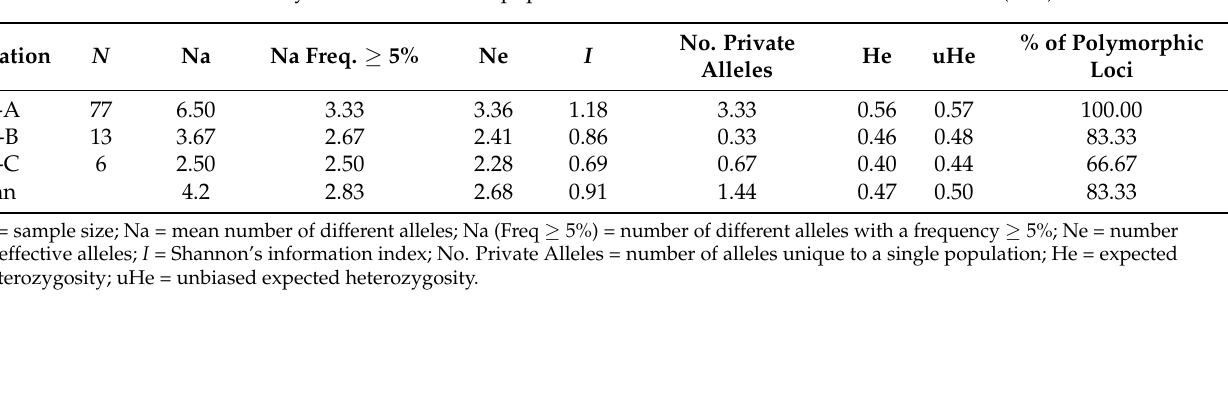
ArR01D MAF (major allele frequency), Gn (number of genotypes), Na (number of alleles), Ne (number of effective alleles), I (Shannon’s information index), Gd (gene diversity), Ho (observed heterozygosity), He (expected heterozygosity), PIC (polymorphic information content), uHe (unbiased expected heterozygosity), Nm (Number of migrant (gene migrant)), F(fixation index), HWE (Hardy–Weinberg equilibrium), probability significance level; ns = not significant, *** p < 0.001.